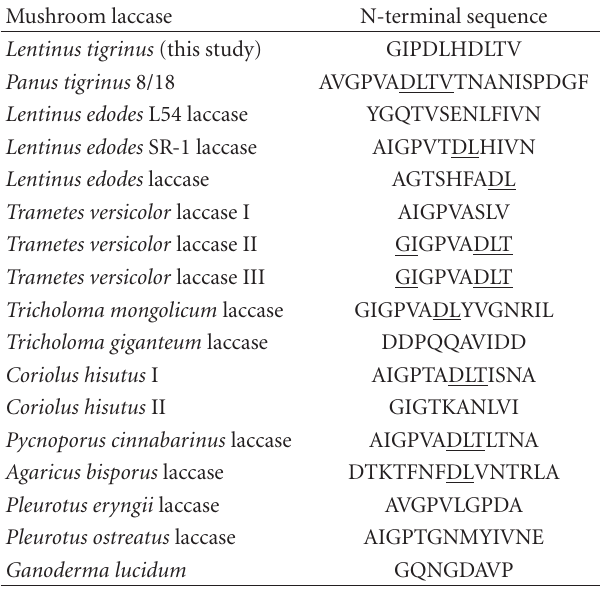
Table 2: N-terminal sequence comparison of Lentinus tigrinus laccase and other mushroom